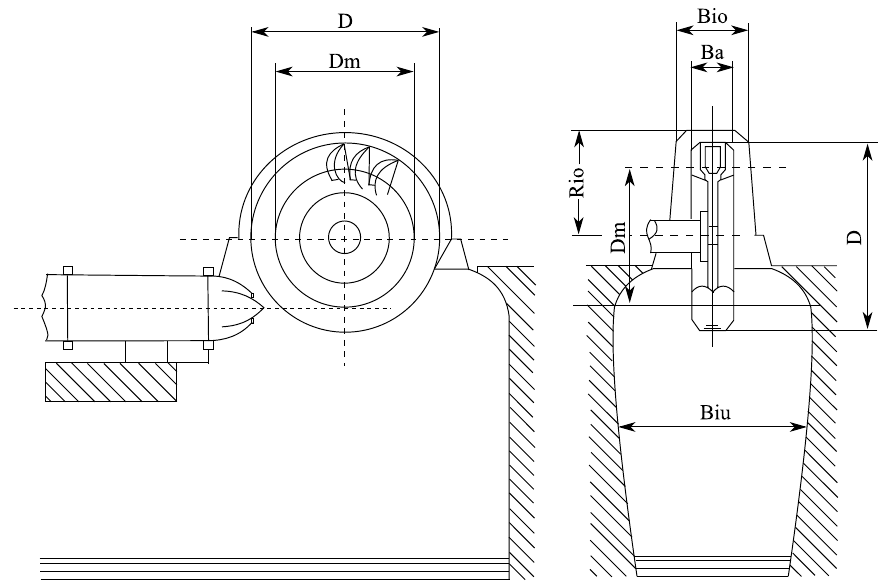
Figure 4. Pelton turbine casing dimensions.